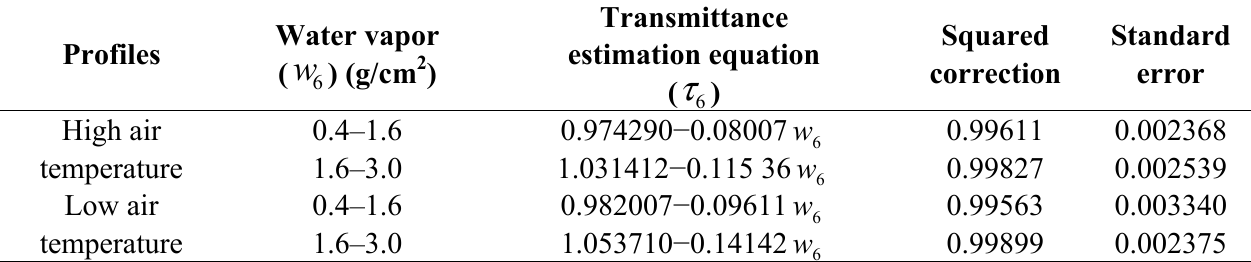
Table 4. Estimation of atmospheric transmittance.